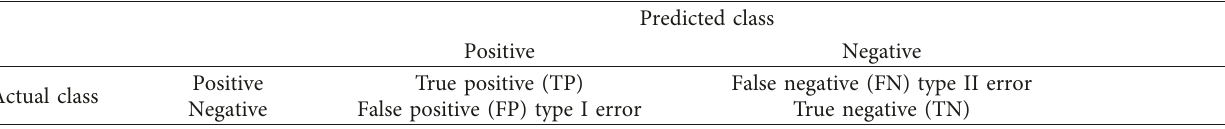
Table 2: Confusion matrix.